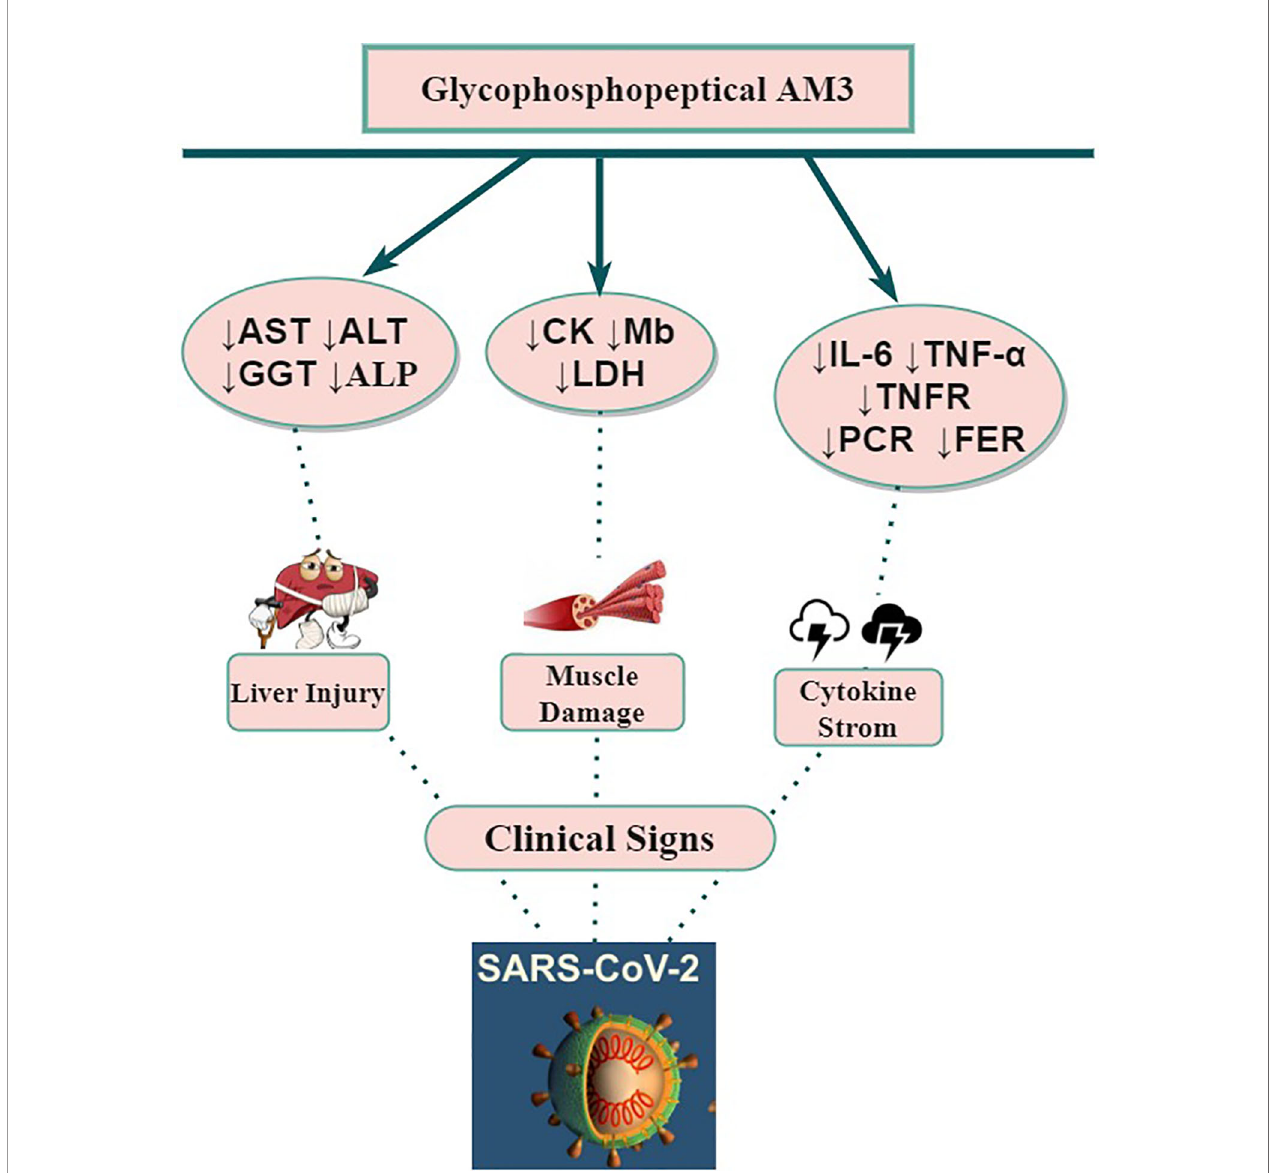
FIGURE 2 | Potential bene fi cial impact(s) of AM3 supplementation on COVID-19 clinical features and outcomes. ALP, Alkaline Phosphatase; ALT, Aspartate Alanine aminotransferase; AST, Aspartate Aminotransferase; CK, Creatine Kinase; Gamma Glutamyl Transpeptidase; IL, Interleukin; LDH, Lactate Dehydrogenase; Mb, Myoglobin; SARS-CoV-2, Severe Acute Respiratory Syndrome-2; TNF, Tumor Necrosis Factor; TNFR, Tumor Necrosis Factor Receptor; ↓ ,